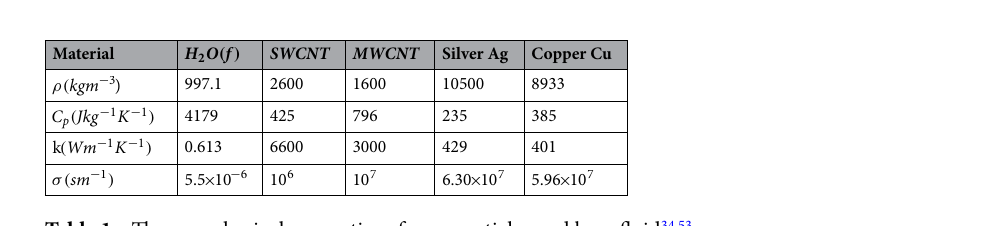
Table 1. Thermo-physical properties of nanoparticles and base fluid 34,53 .